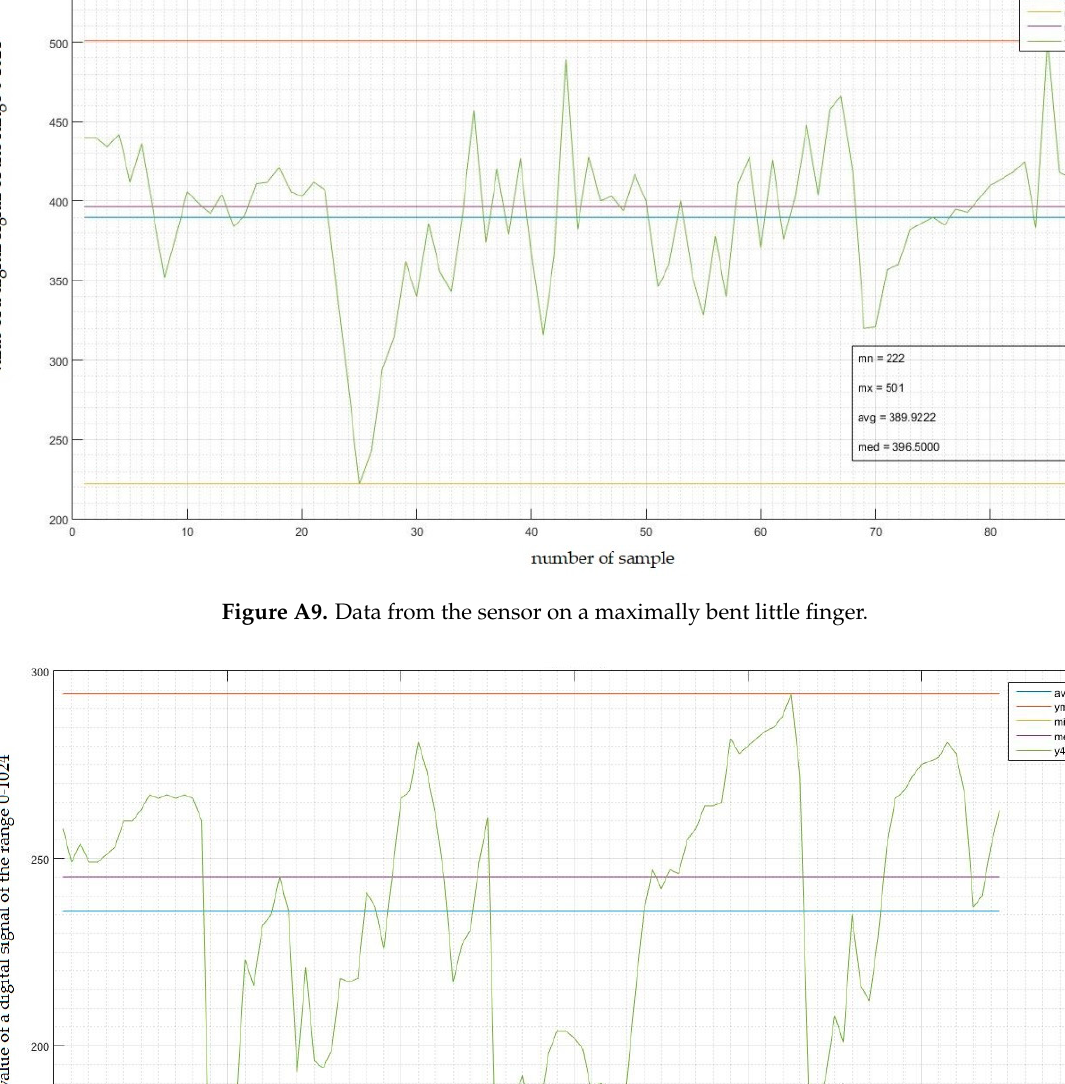
Figure A8. Data from the sensor on a straight ring finger.